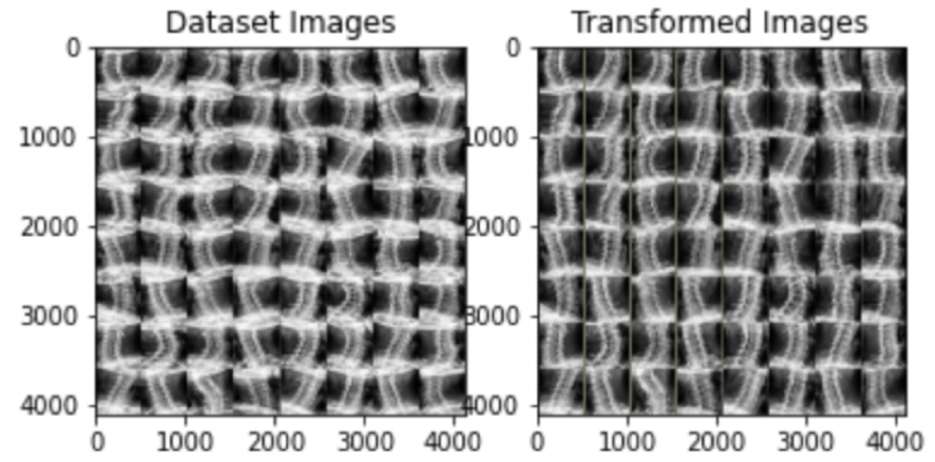
Figure 4. Comparative results before and after STN. Dataset images: before STN; Transformed image: after